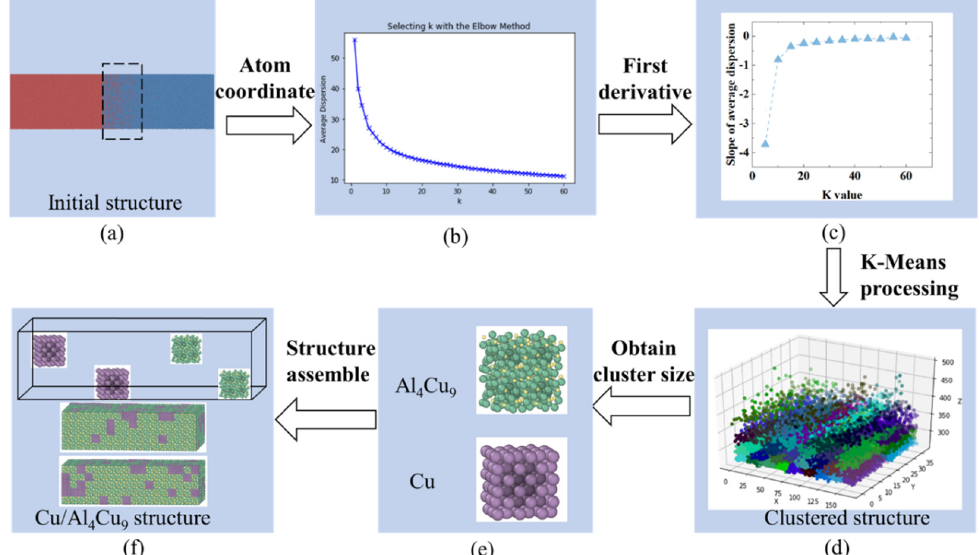
Figure 7. The flow chart of KMeans algorithm to construct the Cu/Al 4 Cu 9 interfacial structures: ( a ) initial structure, ( b ) K value–average dispersion, ( c ) K value–the slope of average dispersion, ( d ) the cluster sturcuture in Python, ( e ) the cluster size of Cu and Al 4 Cu 9 , and ( f ) constructed Cu–Al 4 Cu 9 atomic structure.